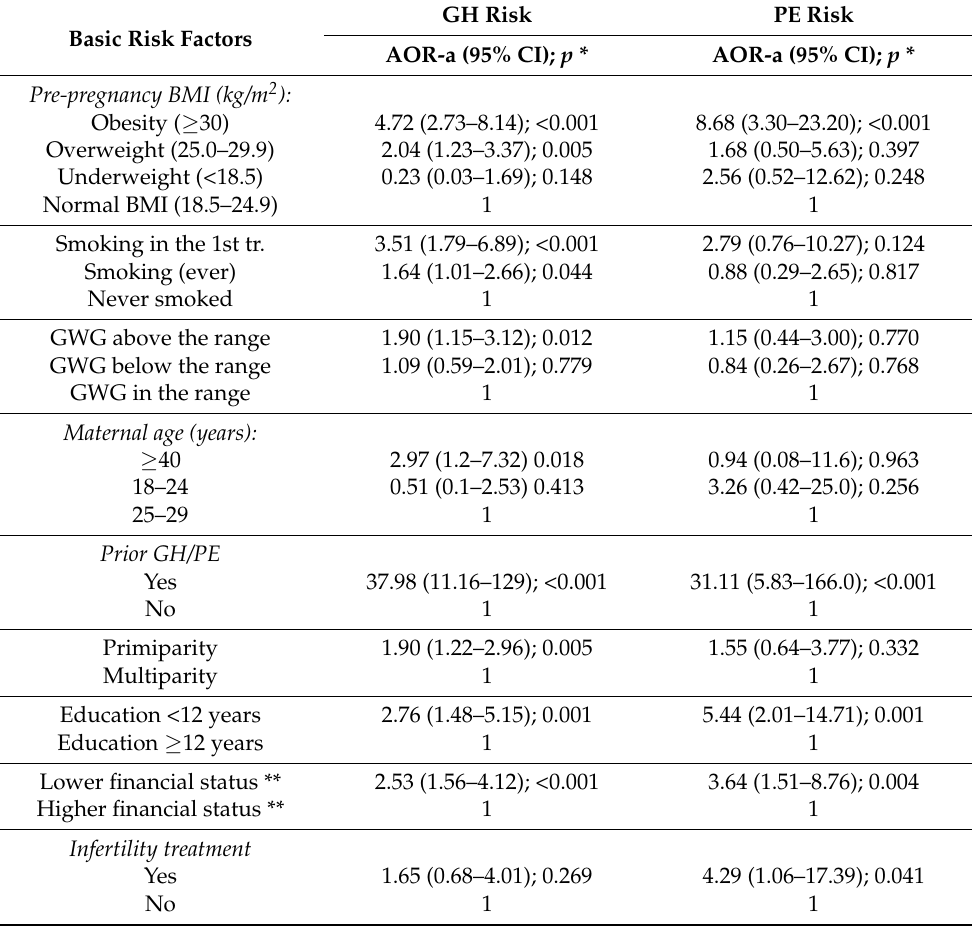
Table 3. The adjusted odds ratios of two forms of pregnancy-induced hypertension for basic risk factors